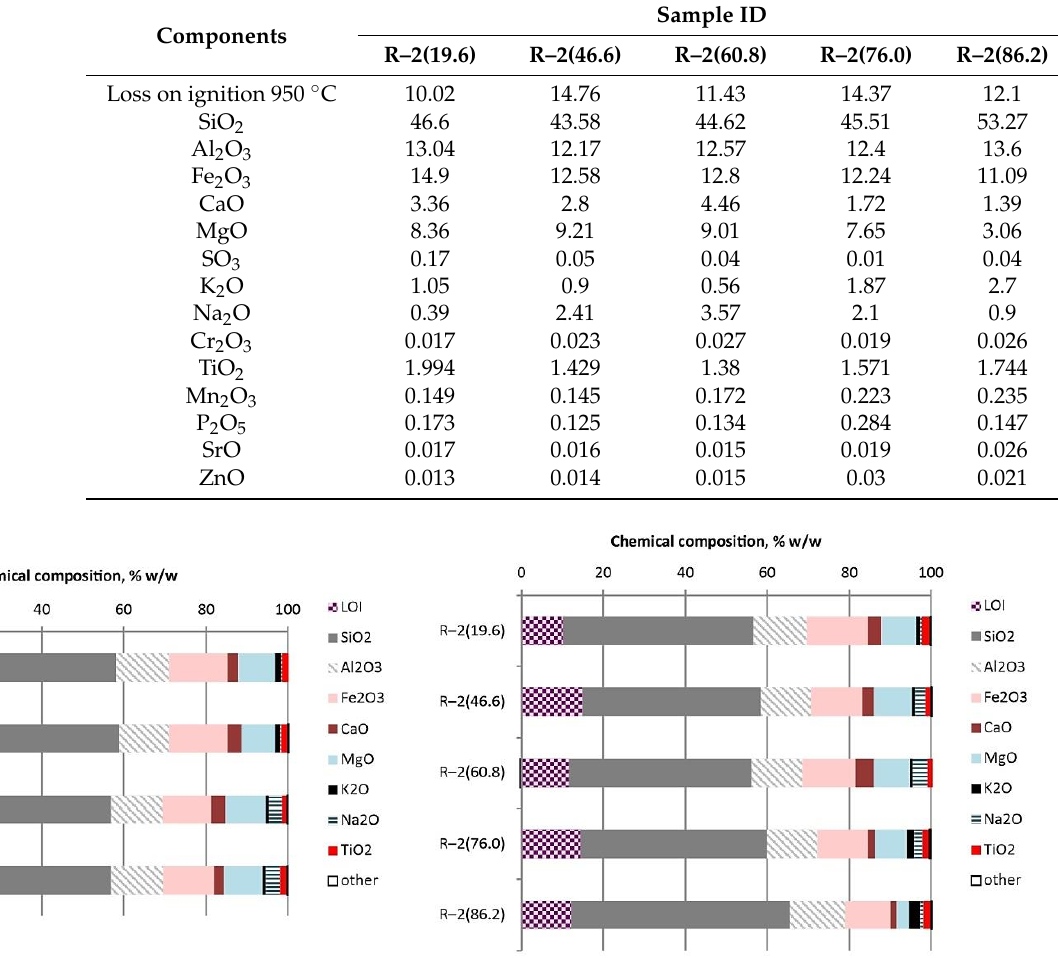
Table 4. Chemical composition of volcanic tuff core samples from Radoshivka–2 well (% w / w ).